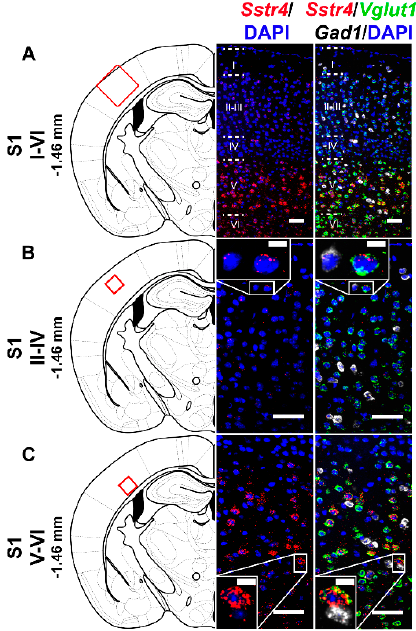
Figure 3. Representative Sstr4 , Vglut1 and Gad1 mRNA expression in the primary somatosensory cortex (S1) of WT mice. Sstr4 (red), Vglut1 (green), and Gad1 mRNA (white) expression counterstained with DAPI are shown in the S1 I–VI (Bregma − 1.46 mm, ( A )), in the S1 II–IV ( B ) and in the S1 V–VI ( C ) ( N = 5). Scale bar: 50 µm, inset scale bar: 10 µm. Selected regions of the descending anti-nociceptive system were also stained for Sstr4 mRNA in mice. The medial preoptic area of the hypothalamus (MPO, Figure 4A) as well as the in the ventrolateral periaqueductal gray matter (VLPAG, Figure 4B) express some Sstr4 mRNA (Figure 4B arrow) not exclusively in Gad1 + neurons (Figure 4B, arrowhead). Sstr4 transcripts were also detected in the noradrenergic (i.e., TH-immunoreactive cells) of the locus coeruleus (LC, Figure 4C). In the raphe magnus nucleus (RMg) few Sstr4 mRNA transcripts were detectable, but did not co-localize with the serotoninergic cells (Figure 4D). The superficial laminae of the spinal dorsal horn contribute also to the descending pain control, and considerable Sstr4 signal was detected here (Figure 4E). These neuroanatomical data support that the main centers of the descending pain control system may be influenced by SST 4 -related mechanisms.